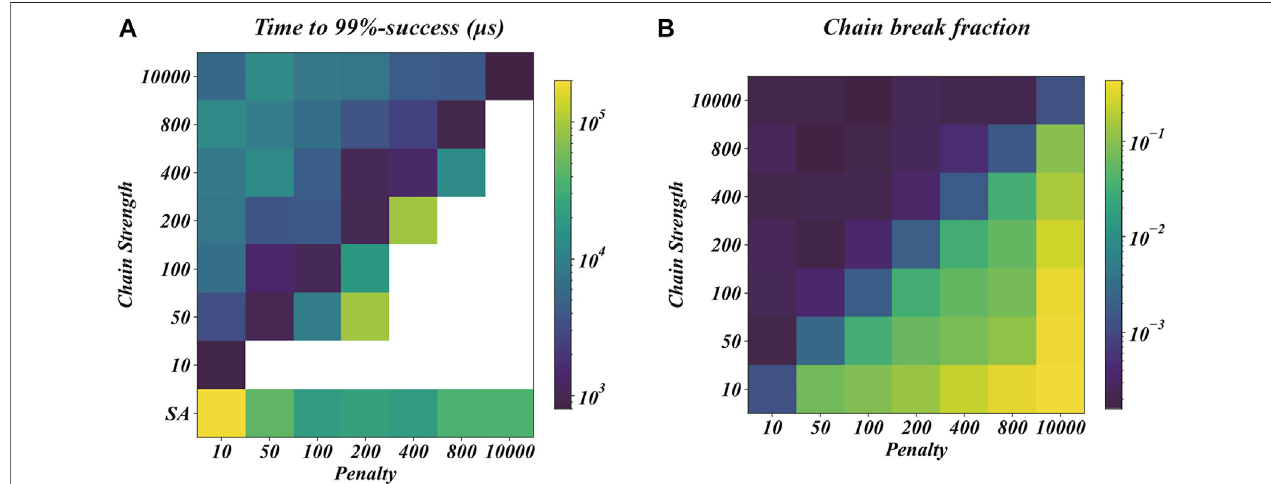
FIGURE 2 | (A) Time to 99 % -success in μ s under different annealing parameters λ 3,4 (penalty coef fi cient) and J chain_strength (chain strength for minor embedding) estimated basedon1,000experimentsonaproblemwith N